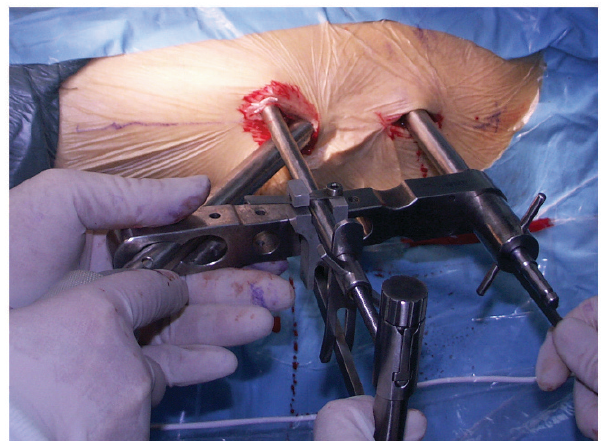
Figure 1 - Intraoperative photograph of one patient. The PCCP was inserted in a submuscular manner and temporarily fixed with a butterfly pin and percutaneous bone hook to the femur via the proximal and distal incisions, respectively. The main sleeve was brought through one of the oblique holes in the proximal plate.